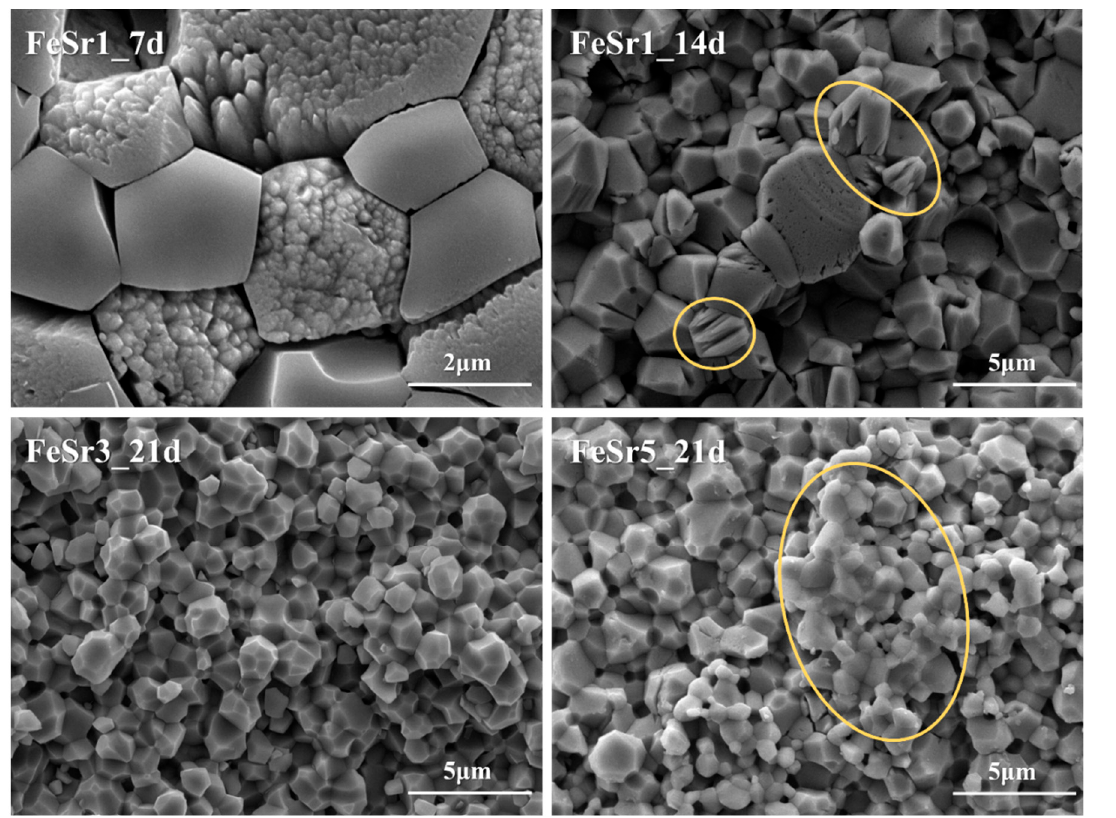
Figure 14. Magnified SEM images of Fe/Sr co-substituted